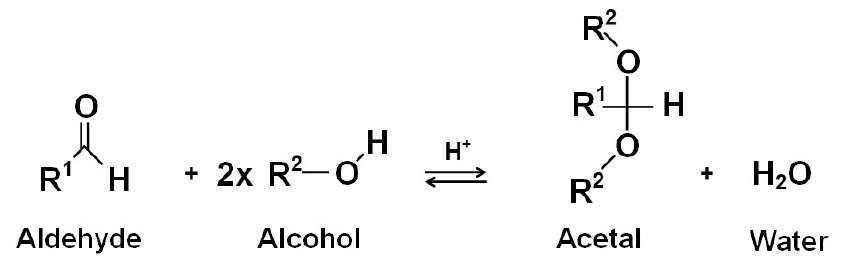
Figure 1. Overall acetalization reaction scheme.